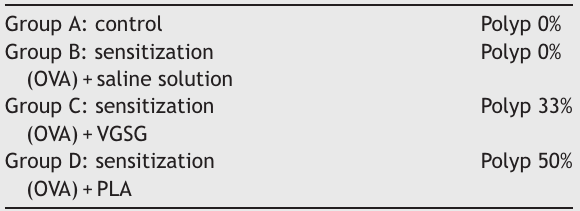
Incidence of rhinosinusitis in the groups of the study by Sejima et al.